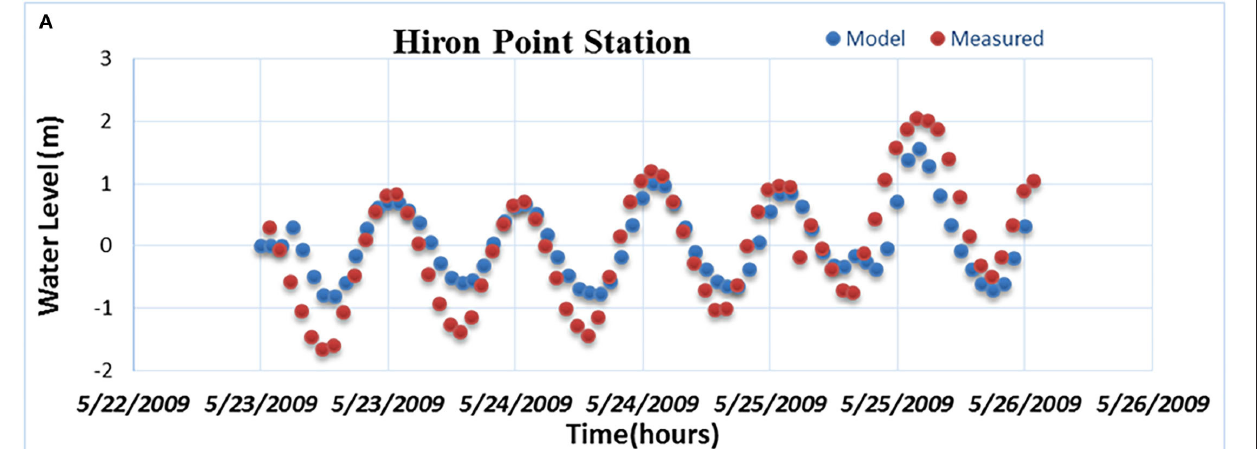
to cyclone Sidr. The simulated inundation maps for cyclones Sidr and Aila are shown in Figures 11 , 12 ,